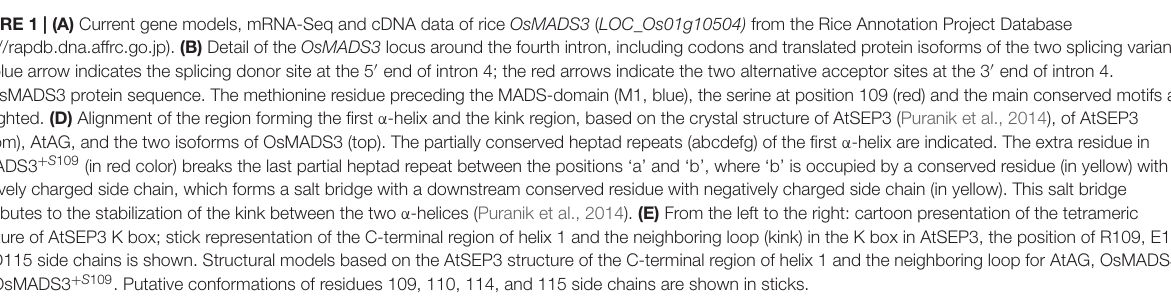
FIGURE 1 | (A) Current gene models, mRNA-Seq and cDNA data of rice OsMADS3 ( LOC_Os01g10504) from the Rice Annotation Project Database (http://rapdb.dna.affrc.go.jp). (B) Detail of the OsMADS3 locus around the fourth intron, including codons and translated protein isoforms of the two splicing variants. The blue arrow indicates the splicing donor site at the 5 (cid:48) end of intron 4; the red arrows indicate the two alternative acceptor sites at the 3 (cid:48) end of intron 4. (C) OsMADS3 protein sequence. The methionine residue preceding the MADS-domain (M1, blue), the serine at position 109 (red) and the main conserved motifs are highlighted. (D) Alignment of the region forming the first α -helix and the kink region, based on the crystal structure of AtSEP3 (Puranik et al., 2014), of AtSEP3 (bottom), AtAG, and the two isoforms of OsMADS3 (top). The partially conserved heptad repeats (abcdefg) of the first α -helix are indicated. The extra residue in OsMADS3 + S 109 (in red color) breaks the last partial heptad repeat between the positions ‘a’ and ‘b’, where ‘b’ is occupied by a conserved residue (in yellow) with positively charged side chain, which forms a salt bridge with a downstream conserved residue with negatively charged side chain (in yellow). This salt bridge contributes to the stabilization of the kink between the two α -helices (Puranik et al., 2014). (E) From the left to the right: cartoon presentation of the tetrameric structure of AtSEP3 K box; stick representation of the C-terminal region of helix 1 and the neighboring loop (kink) in the K box in AtSEP3, the position of R109, E110 and D115 side chains is shown. Structural models based on the AtSEP3 structure of the C-terminal region of helix 1 and the neighboring loop for AtAG, OsMADS3 and OsMADS3 + S 109 . Putative conformations of residues 109, 110, 114, and 115 side chains are shown in sticks.